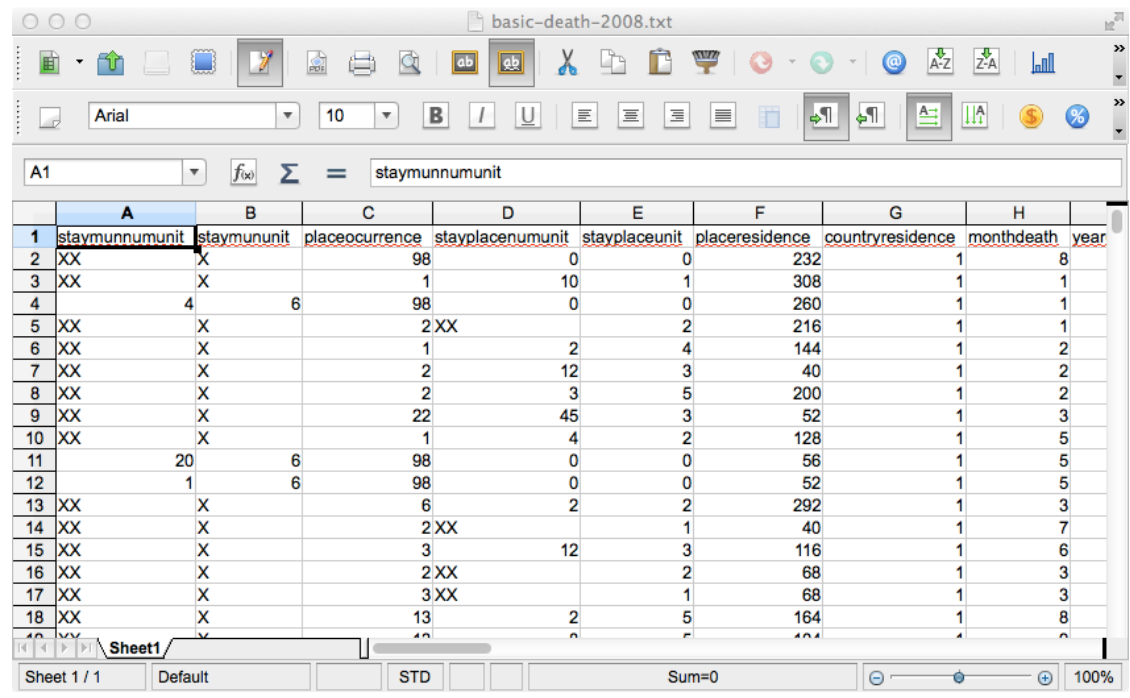
Figure 1. A portion of the Puerto Rico Basic Mortality file for year 2008. The full file contains 29,100 records.